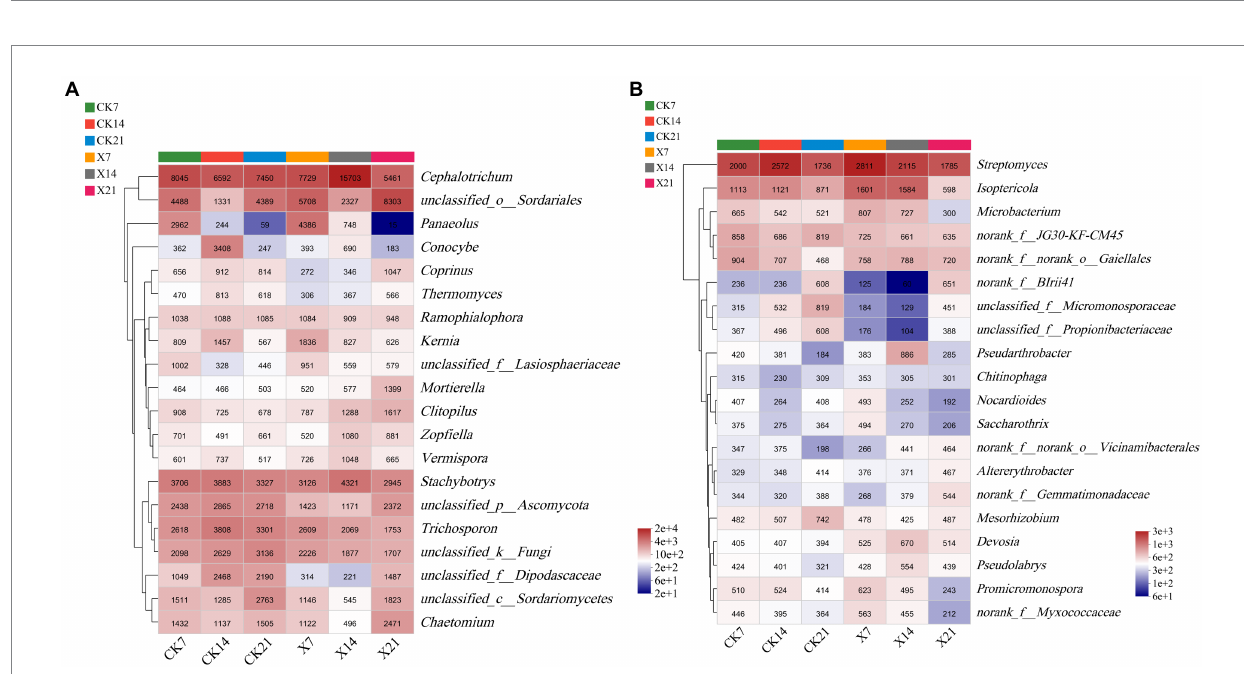
FIGURE 9 Community heatmap analysis on genus level. (A) Fungal community. (B) Bacterial community. X refers to C. cateniannulata X8 treatment, CK refers to the control, and the number indicates the time point after